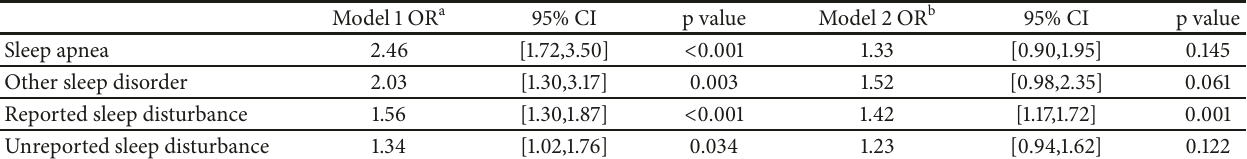
Table 3: Logistic regression predicting odds of CRP > 1 mg/dL.